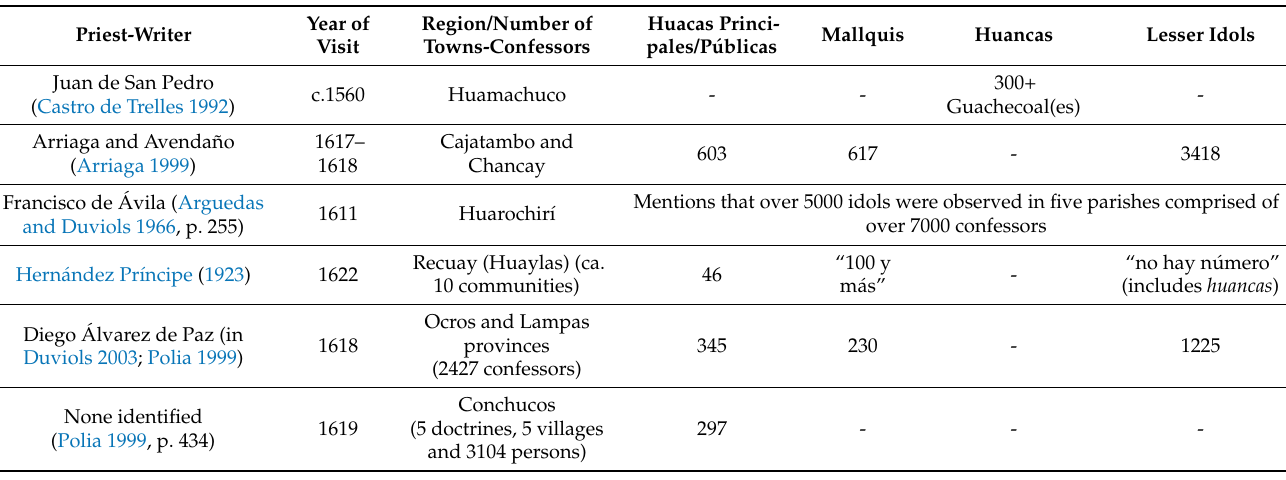
Table 1. Numbers of idols tabulated in church visits to highland regions and parishes therein.